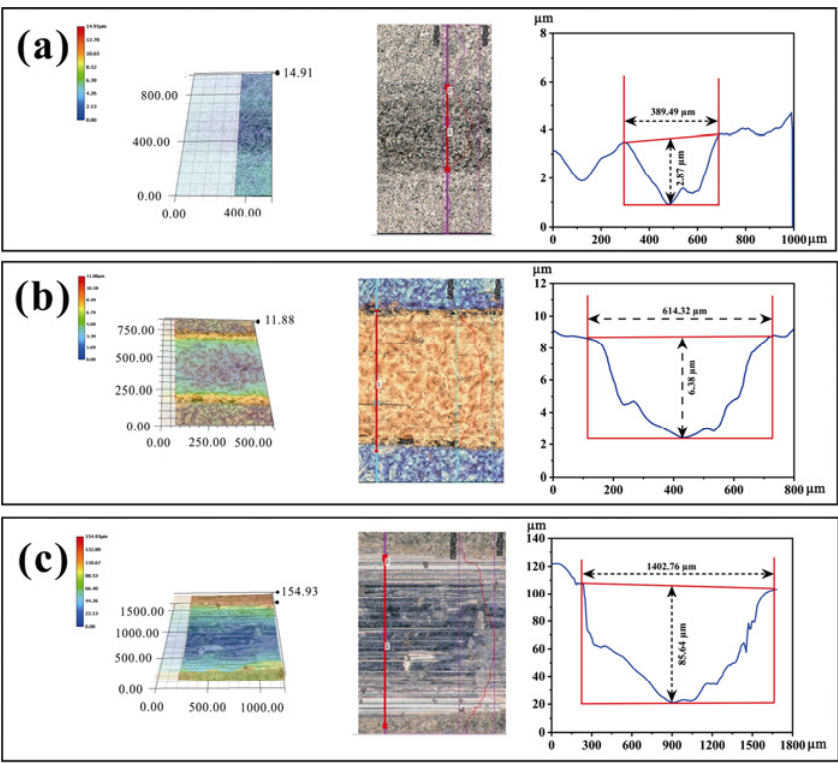
Fig. 11 3D topographies and corresponding 2D profile curves of worn surfaces of high-entropy (TiVNbMoW)C 4.375 at (a) RT, (b) 400 ℃ , and (c) 800 ℃ .